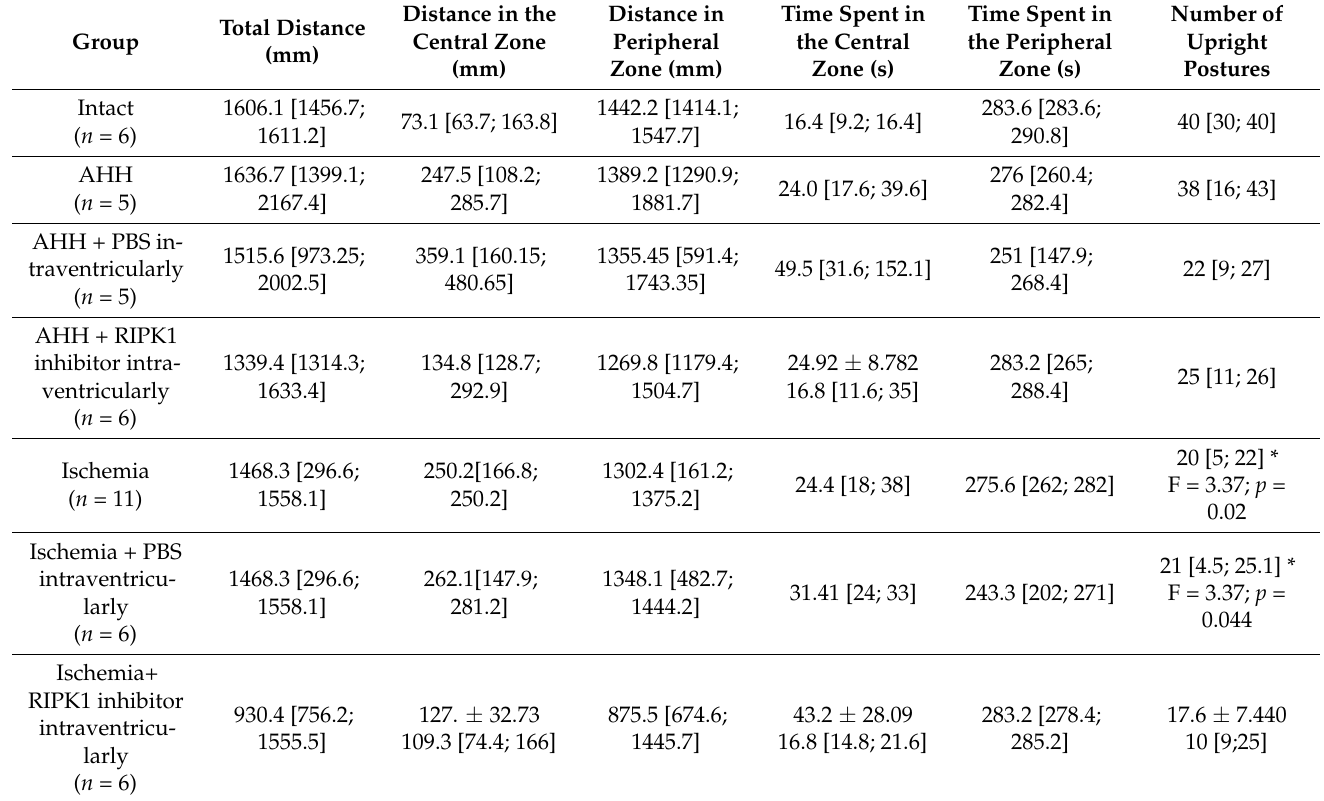
Table 2. The main types of motor and orientation-exploratory activity of animals after modeling acute hypobaric hypoxia and